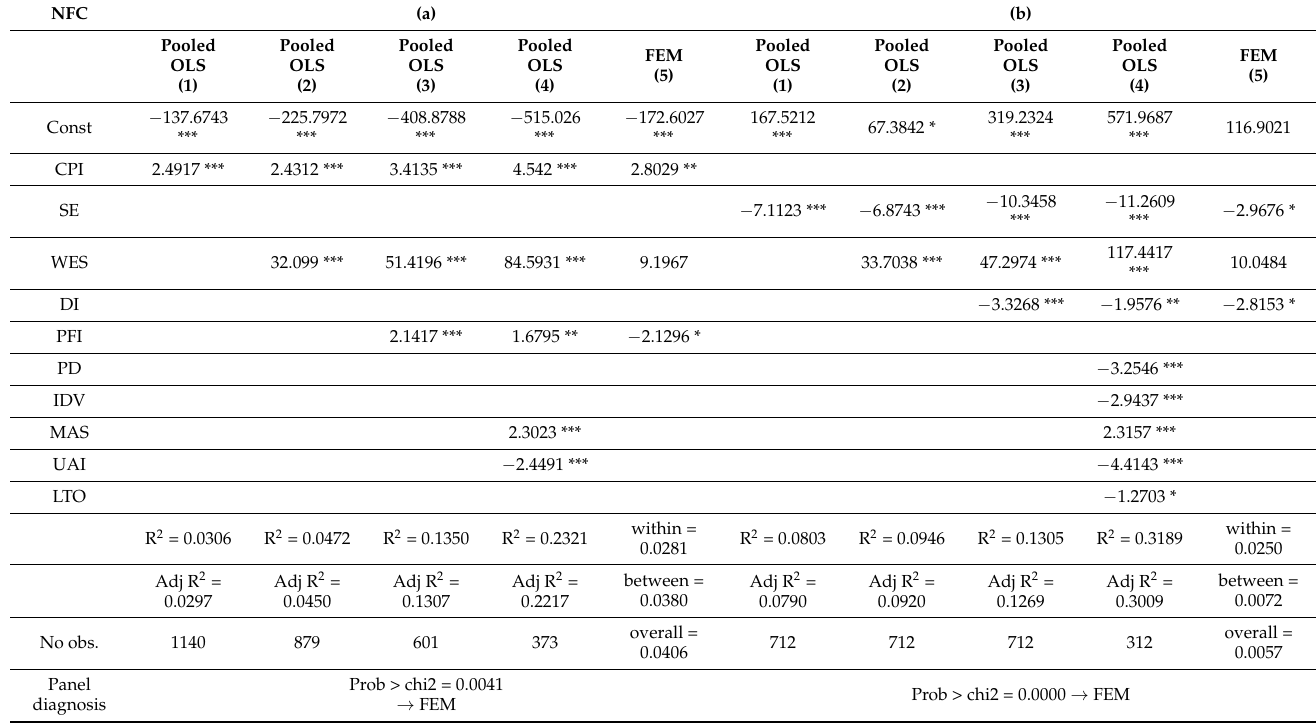
Table 5. Simple and multiple